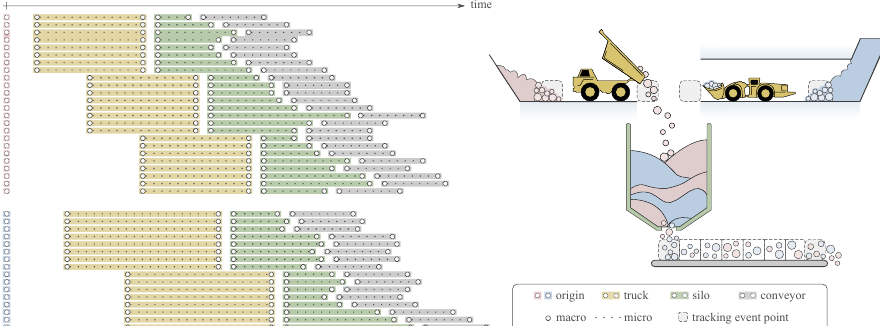
Figure 2. Illustration of micro- and macro-tracking. The sparse macro-tracking events include the appearance of fragmented material at the source (pink or blue) after blasting, haul truck asset dispatching and dumping (yellow), material entering later being discharged from a storage asset (green) and a conveyor asset (grey). The micro-tracking is the relatively high-frequency tracking of the material moving with or flowing inside an